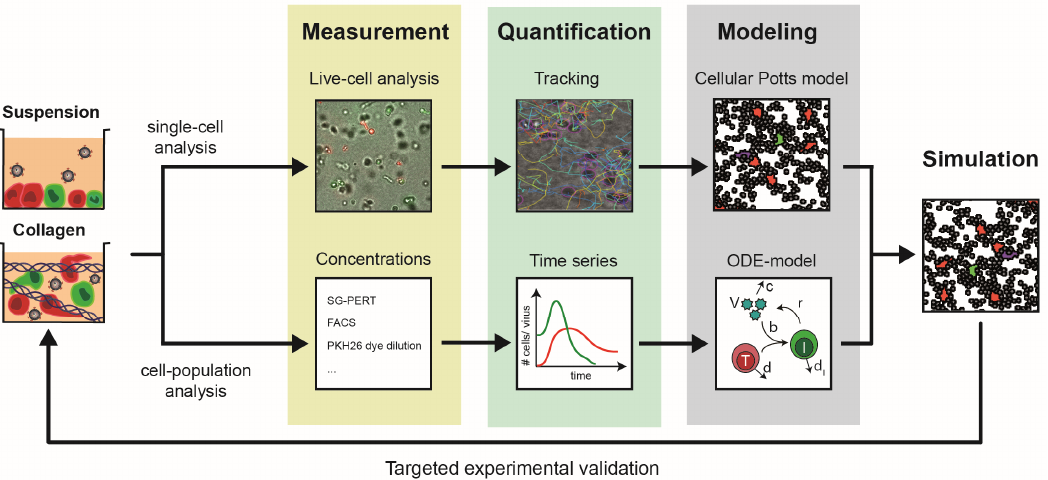
Figure 2. Schematic of the INSPECT-3D workflow that combined single-cell and cell-population measurements by mathematical modeling to reveal the dynamics of infection spread. Infected and non-infected Peripheral Blood Mononuclear Cells (PBMCs) were cultured in suspension or collagen cultures at a 1:20 ratio. In suspension cultures, cells rapidly settled at the bottom of the culture dish to form dense 2D monolayers. In collagen, cells were spatially separated from another, migrated along the 3D scaffold, and eventually made contact with other cells. Measurements from live-cell imaging of single cells and bulk dynamics allowed quantification of individual cell motilities and interactions, as well as long-term kinetics of viral load and cell concentrations. Appropriate mathematical model systems that either rely on spatially resolved cellular Potts models describing single-cell behavior or systems of ordinary differential equations (ODE) enabled us to disentangle processes of cell motility, cellular turnover, and viral transmission and replication. Theses analyses led to an integrative computational model for HIV-1 spread that provides a mechanistic and quantitative understanding of viral transmission within these multicellular systems. Recurrent experimental validation of model predictions by in silico manipulation of experimental conditions was used to refine the model system and reveal key processes governing the dynamics of HIV-1 spread.